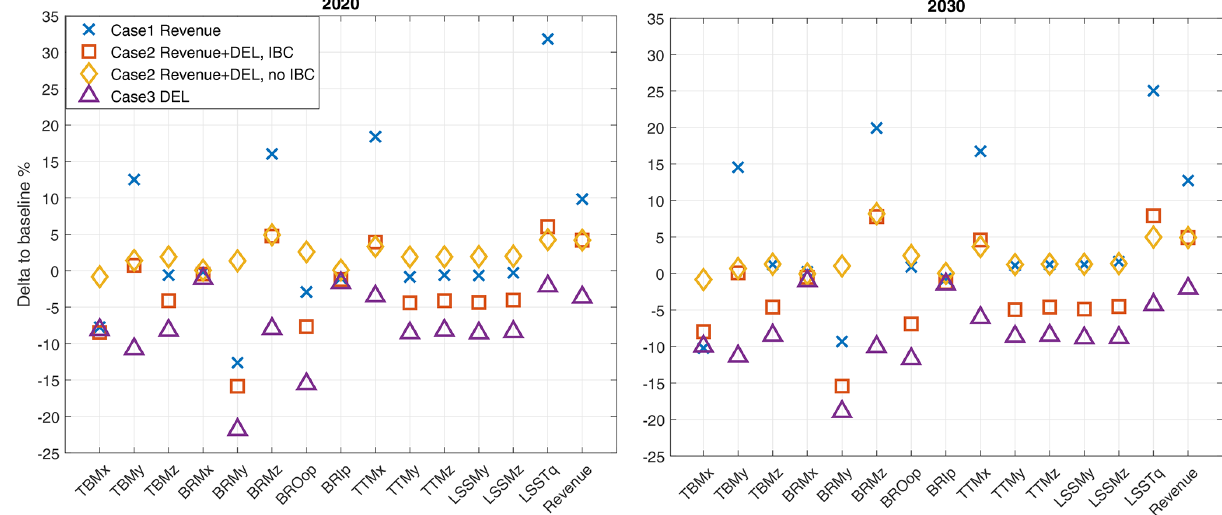
Figure 4. Cumulative values of damage equivalent loads (DELs) and revenue for operation of a single wind turbine with different objectives, in relation to the baseline operation. TBMx: tower bottom side-to-side moment, TBMy: tower bottom fore–aft moment, TBMz: tower bottom torsion, BRMx: blade root edgewise moment, BRMy: blade root flapwise moment, BRMz: blade root torsion, BROop: blade root out-of- plane moment, BRIp: blade root in-plane moment, TTMx: tower top roll moment, TTMy: tower top pitch moment, TTMz: tower top yaw moment, LSSMy: non-rotating low-speed shaft bending moment about the y axis, LSSMy: non-rotating low-speed shaft bending moment about the z axis, LSSTq: low-speed shaft